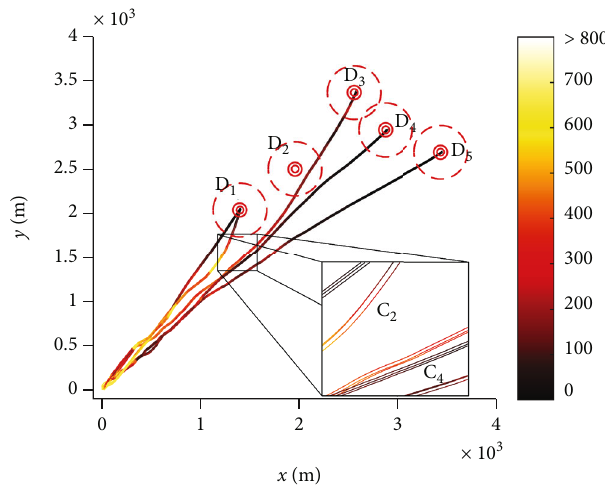
Figure 12: Proportion of correct predictions.